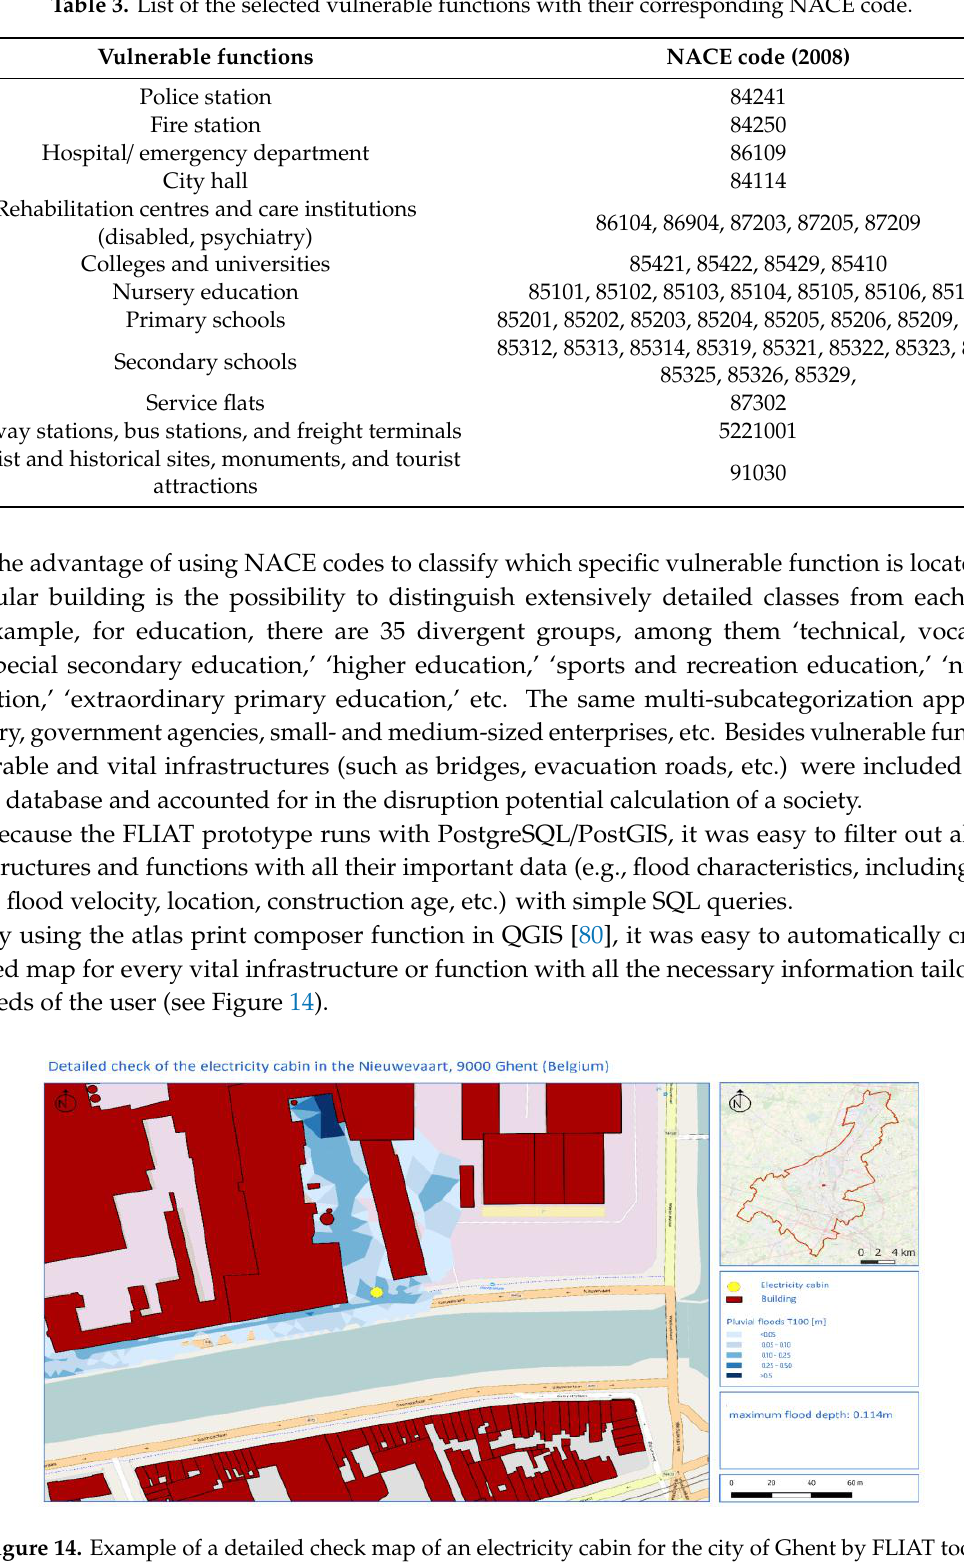
Table 3. List of the selected vulnerable functions with their corresponding NACE code.